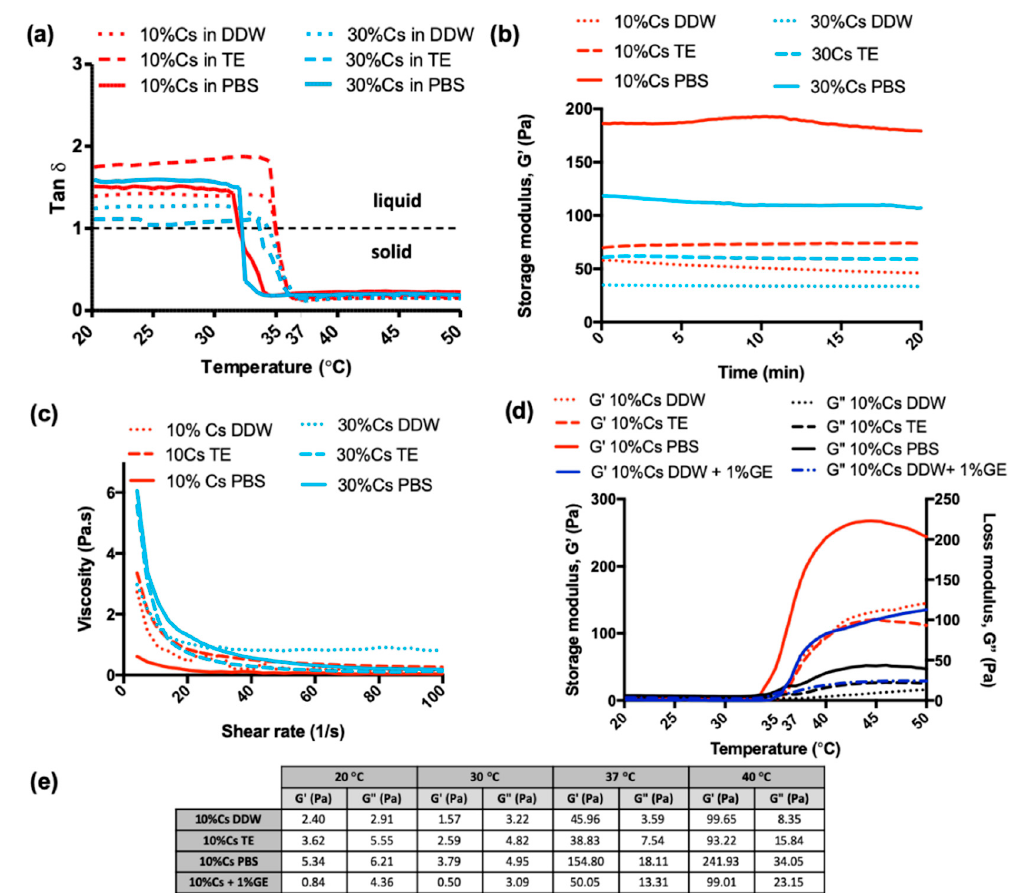
Figure 4. Rheological characterization of Cs-g-PNIPAAm: ( a ) Tan δ of gel as a function of temperature achieved using ramp temperature analysis, where the tan δ value shifted from a value > 1 to a value < 1. Dashed line represents equilibrium state of the gel when liquid solution and solid gel phases were equal (G (cid:48) = G”). ( b ) Hydrogel stability assessed via time sweep at 37 ◦ C over a 20 min period. ( c ) Viscosity of gels in liquid state at 20 ◦ C. ( d ) Dynamic temperature sweep of Cs-g-PNIPAAm copolymers in PBS, DDW, and Tris-EDTA (TE) bu ff er demonstrating ability to modulate mechanical properties while maintaining consistent sol-gel transition point. ( e ) Shear storage modulus (G’) and shear loss modulus (G”) values extracted from the dynamic temperature